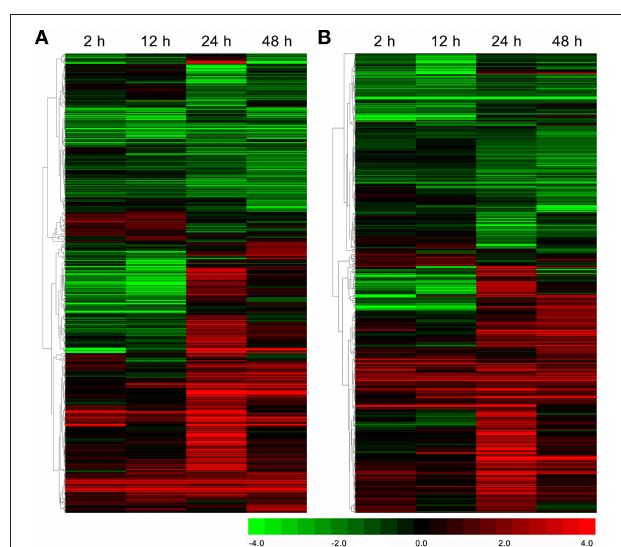
FIGURE 4 | Hierarchical clustering analysis of the relative expression levels of the DEGs related to amino acid metabolism (A) and secondary metabolism (B) in C. sinensis leaves under drought stress. The FPKM ratio of unigene expression is represented on a logarithmic scale for each treatment period (2, 12, 24, or 48h) and the control (0h). Red indicates that a gene was up-regulated at that stage, whereas green indicates down-regulated